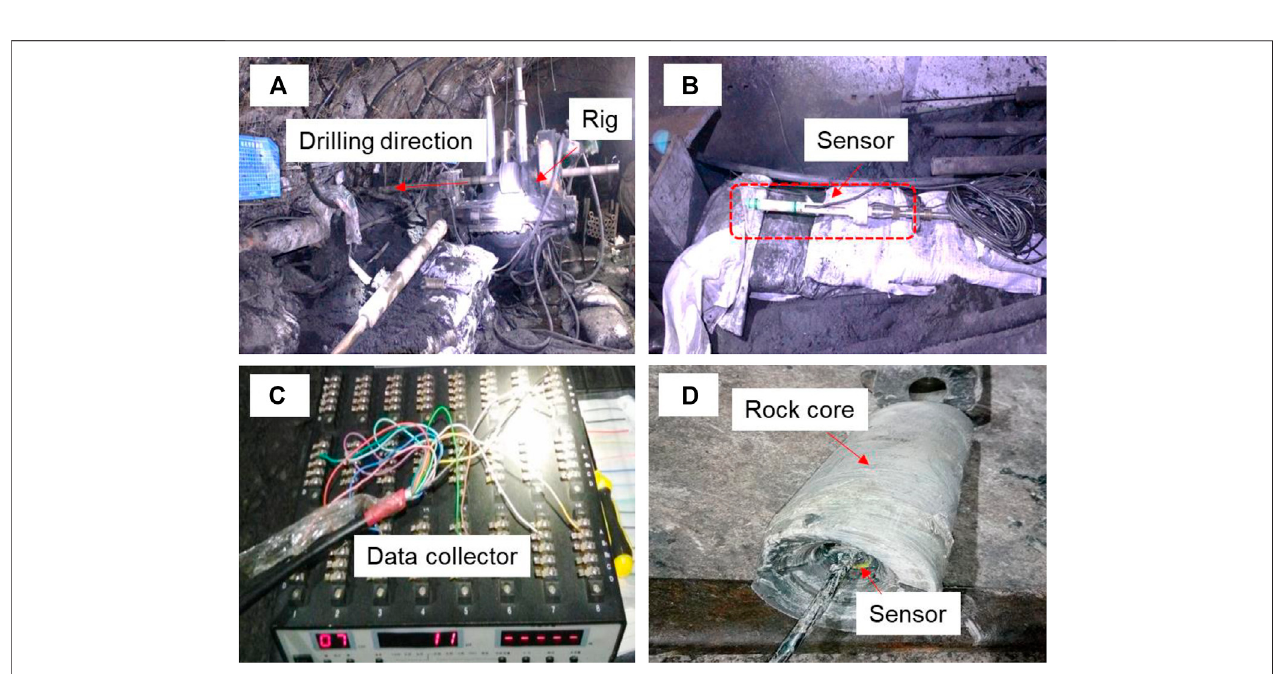
FIGURE 5 | The test procedure of borehole relief method. (A) Drill the boreholes. (B) Sensor for stress measurement. (C) Data collector for the sensor. (D) Rock core drilled from borehole.